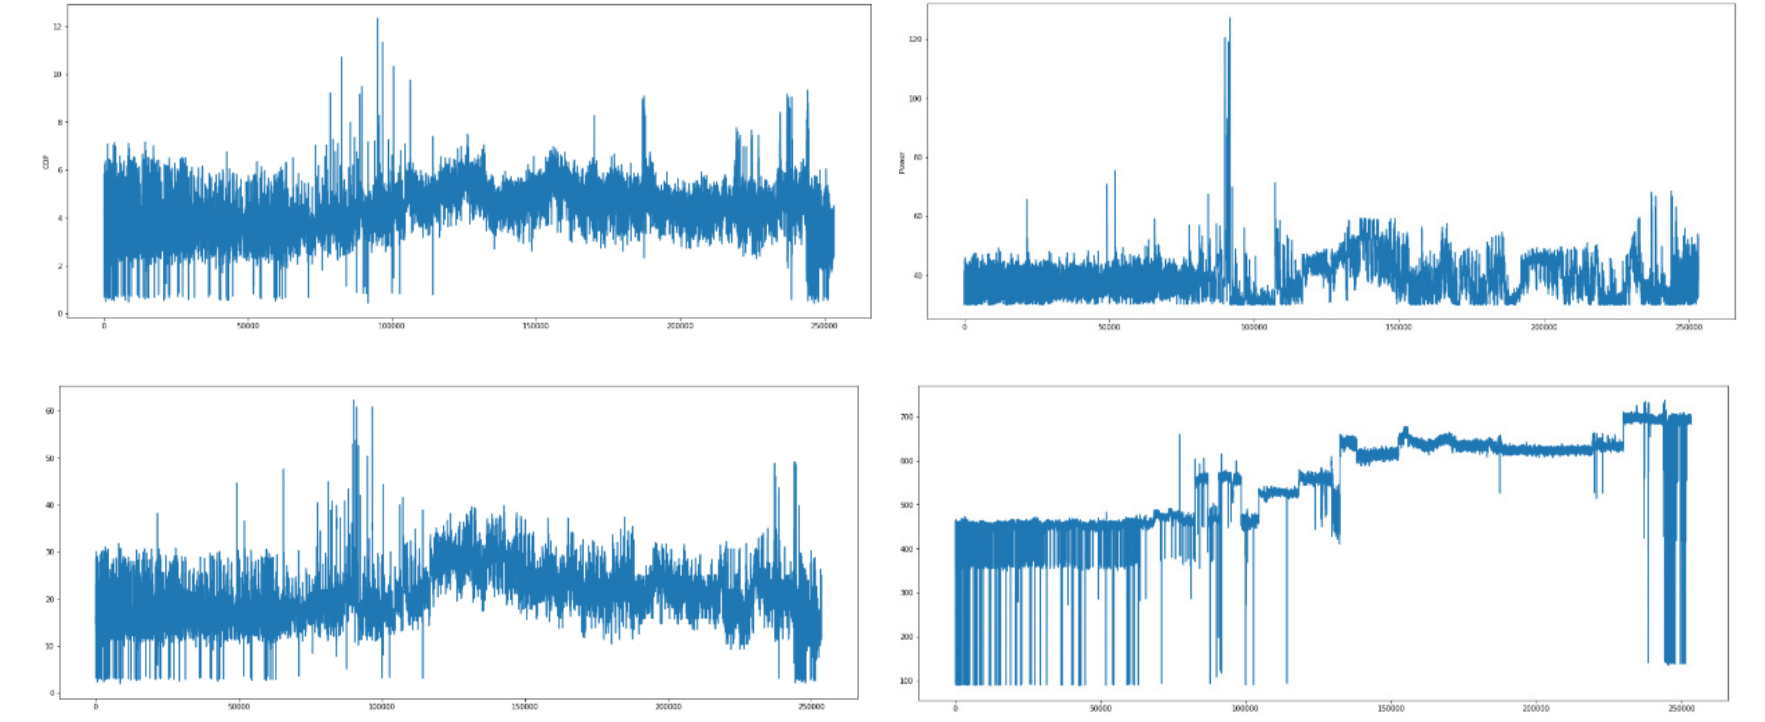
Figure 2. Trend chart of the key variables of chiller system.